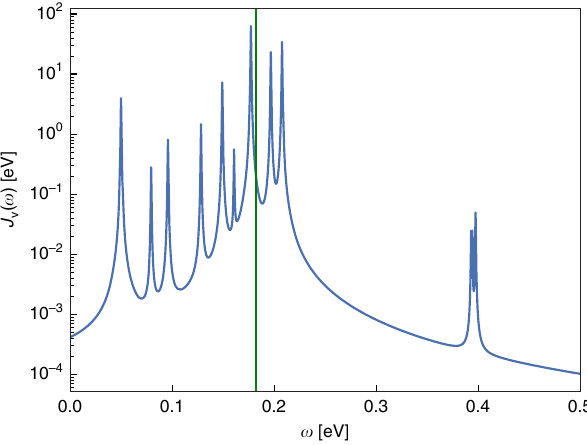
Fig. 7 Anthracene spectral density. J v ( ω ) for the anthracene molecule. The vertical green line indicates the vibrational frequency ω v of the reaction